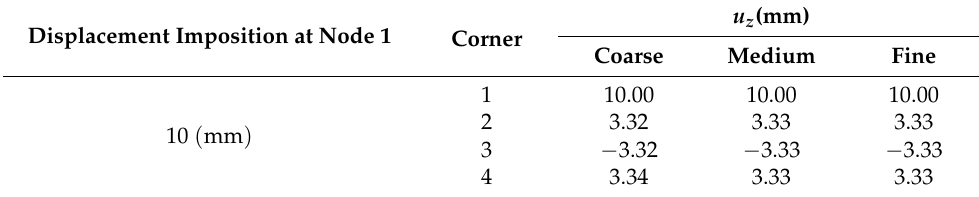
Table 7. Displacement along z -direction for different mesh densities of